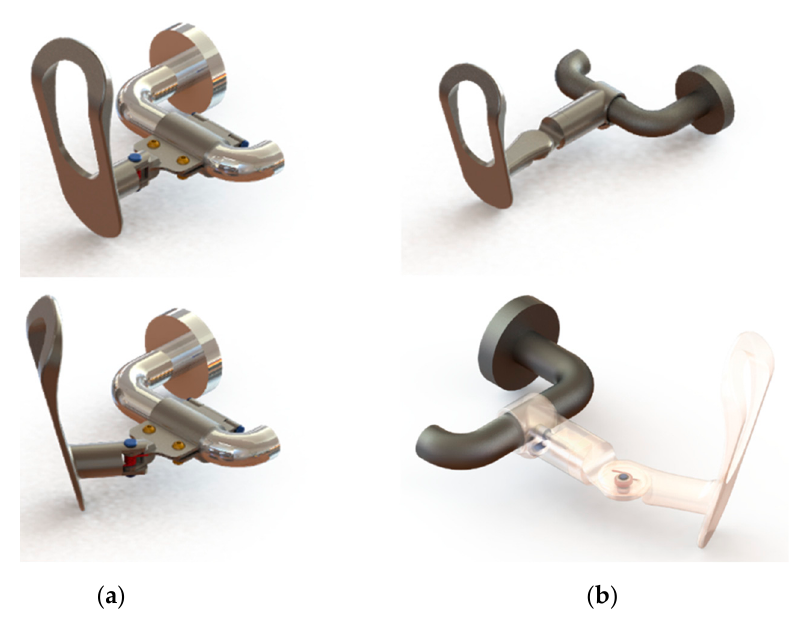
Figure 4. ADOD-V3 system: ( a ) simple version; ( b ) refined version.